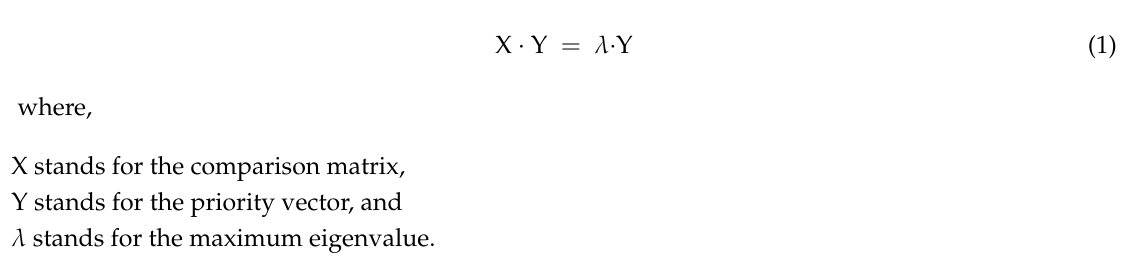
Jeddah city (source: Author, 2019).